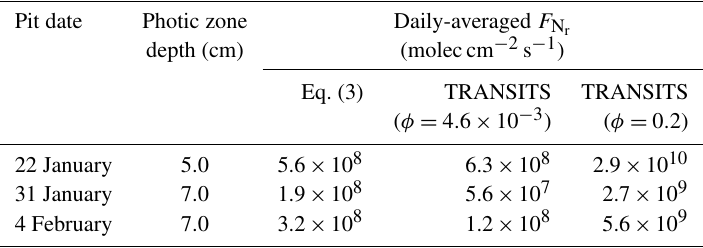
calculated using Eq. (3) and the TRANSITS model on 22, 31 January, r